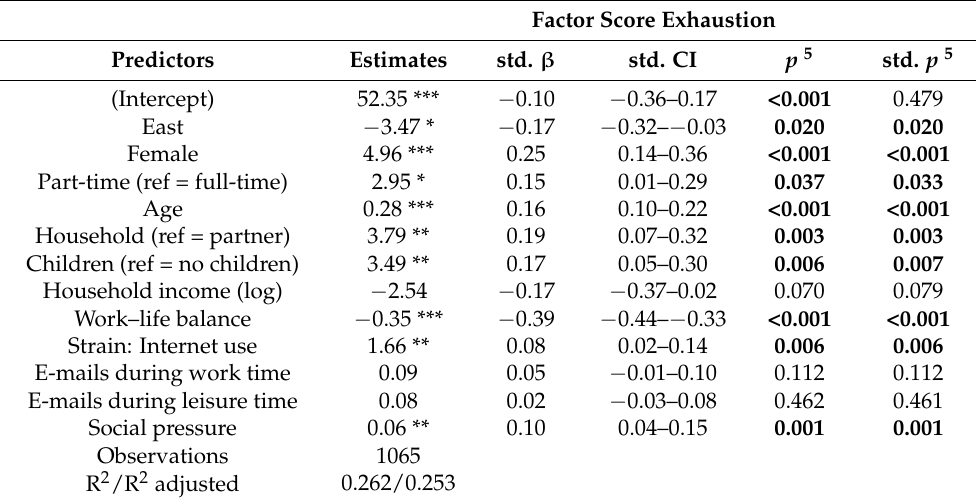
Table 4. Ordinary least squares regression: predictors of